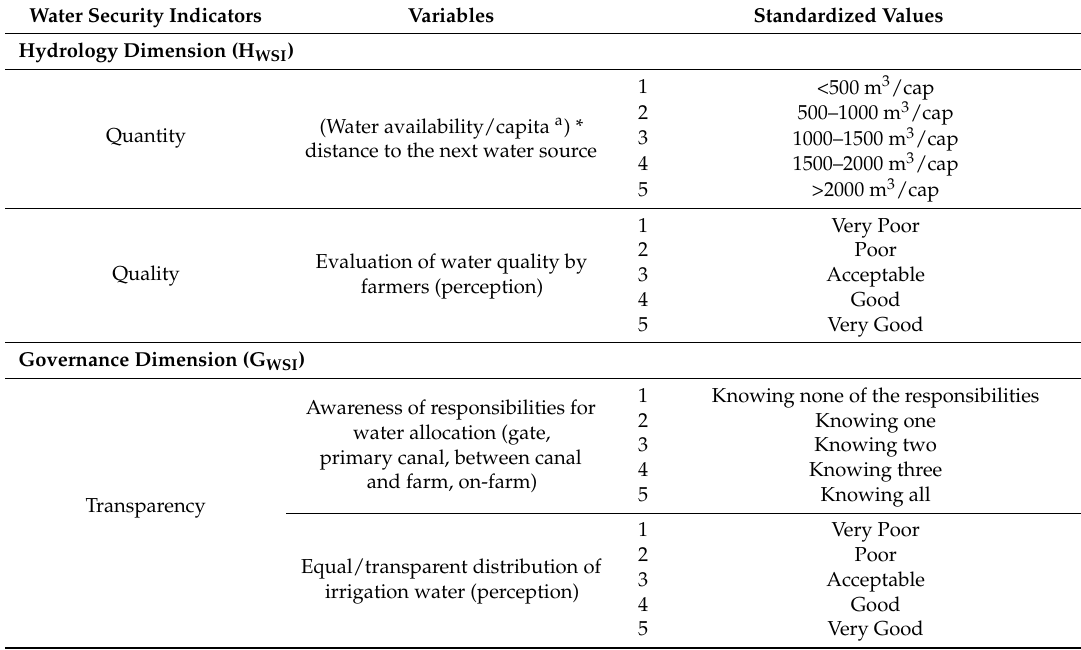
Table 1. Operationalizing the three dimensions of irrigation water